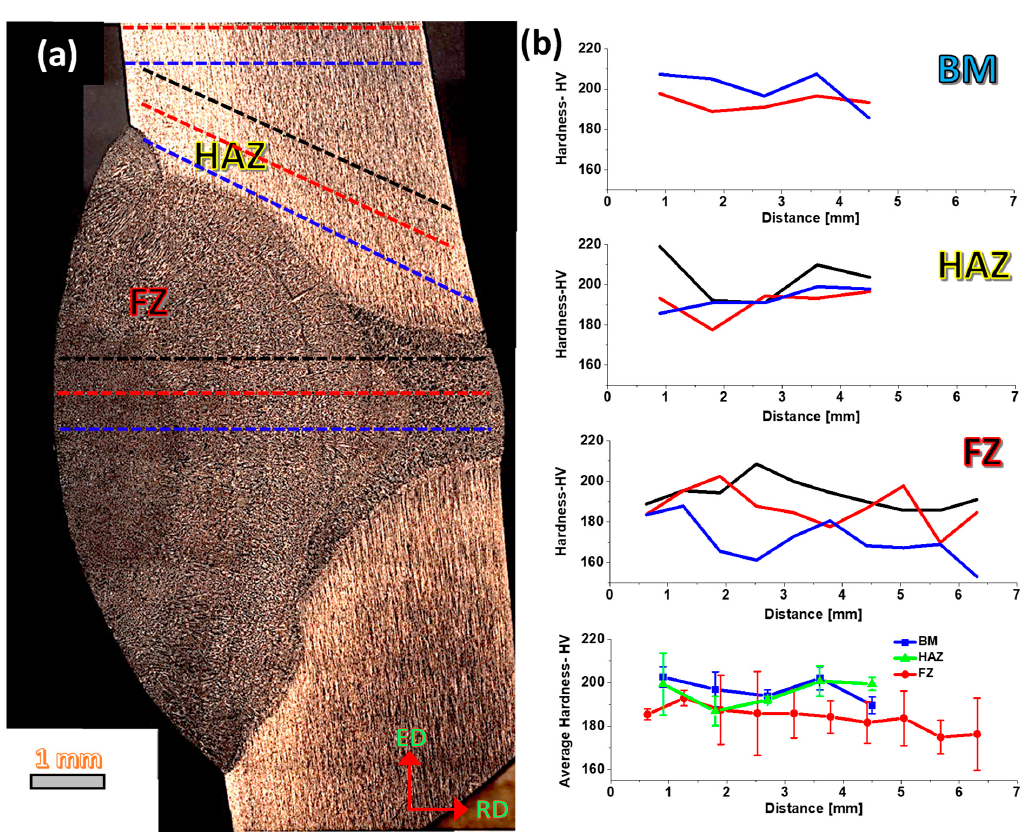
Figure 8. ( a ) hardness profiles localization and ( b ) hardness measurements on the different zones and the average curve for each zone (doted lines in figure ( a ) do not correspond to the exact path and location where the hardness profiles were obtained, they are just used as an illustration